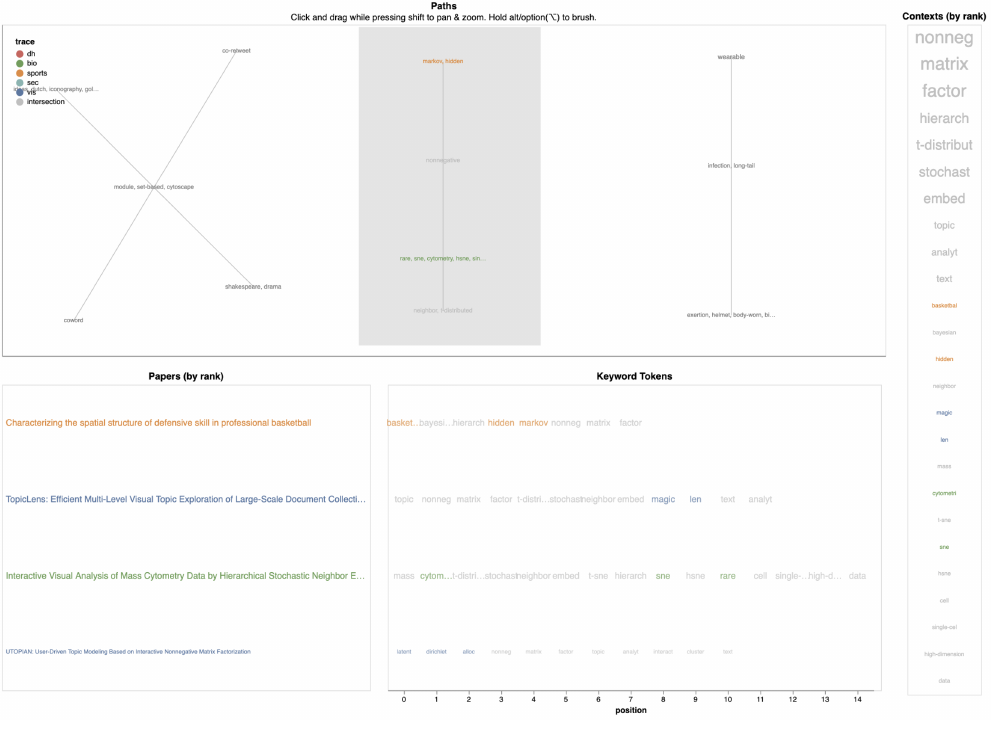
Figure 11. Close view of component #4 in GlassViz’s main view. We encourage readers to download the high-resolution images companion to this paper which can be zoomed and explored to get a better understanding of how GlassViz